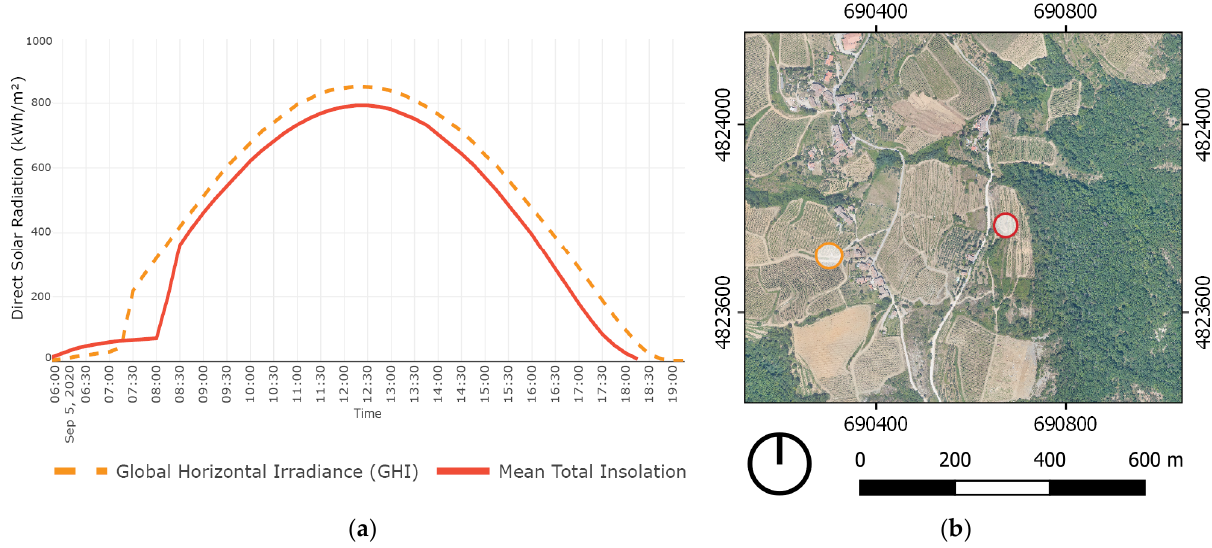
Figure 2. ( a ) Graph illustrating the comparison between the outcomes of the SAGA GIS potential incoming solar radiation analysis of an exposed location in Grospoli II vineyard (marked with red, continuous line) and global horizontal irradiance (GHI) measured by the local meteorological station in Lamole (marked with orange, dashed line). ( b ) Map illustrating the chosen location in Grospoli II vineyard (marked in red) and the exact location of the local meteorological station in Lamole (marked in orange).